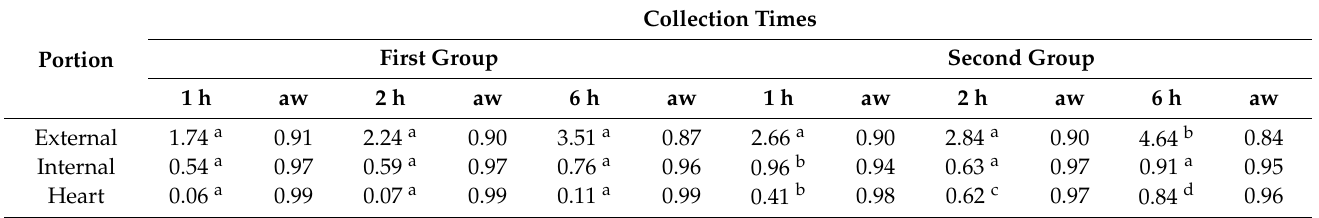
Table 3. NaCl concentration (%) in swordfish fillets after dry salting followed by rinsing and storage.